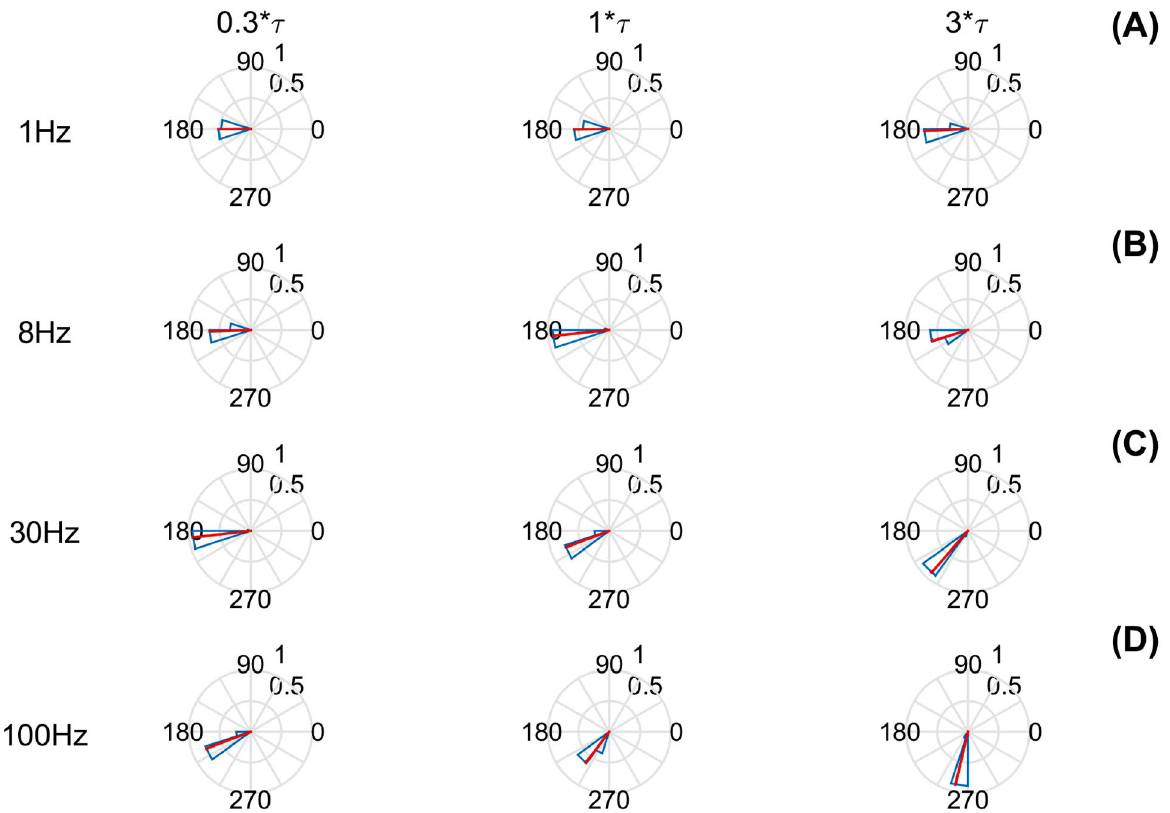
Figure 2. Subthreshold circular statistics for different parameters of characteristic times and frequencies. The characteristic time of the neuronal membrane has a defined value based on the experimental data present in the literature. Such values represent an increase (greater than 1) or a reduction (less than 1) of the LFP-type response speed model characteristic of ephaptic entrainment. In addition, we show how the various values of the frequency parameters of the input signal induce a phase difference. The columns show the circular statistics for a membrane: 0.3 times, 1 times, 3 time what is reported in the literature, with the associated frequencies (In the lines ( A ) 1 Hz, ( B ) 8 Hz, ( C ) 30 Hz, and ( D ) 100 Hz). In all results we chose the fixed amplitude (100 nA) and noise (20 dB) intensities that best suit the results of the experimental results. To guide the eyes and reference the intensity of the statistical value of the phase difference (red), all graphs show, on the right and above, two numbers (between 0 and 1) related to the radius size of the inner and outer circle, respectively. Frequency